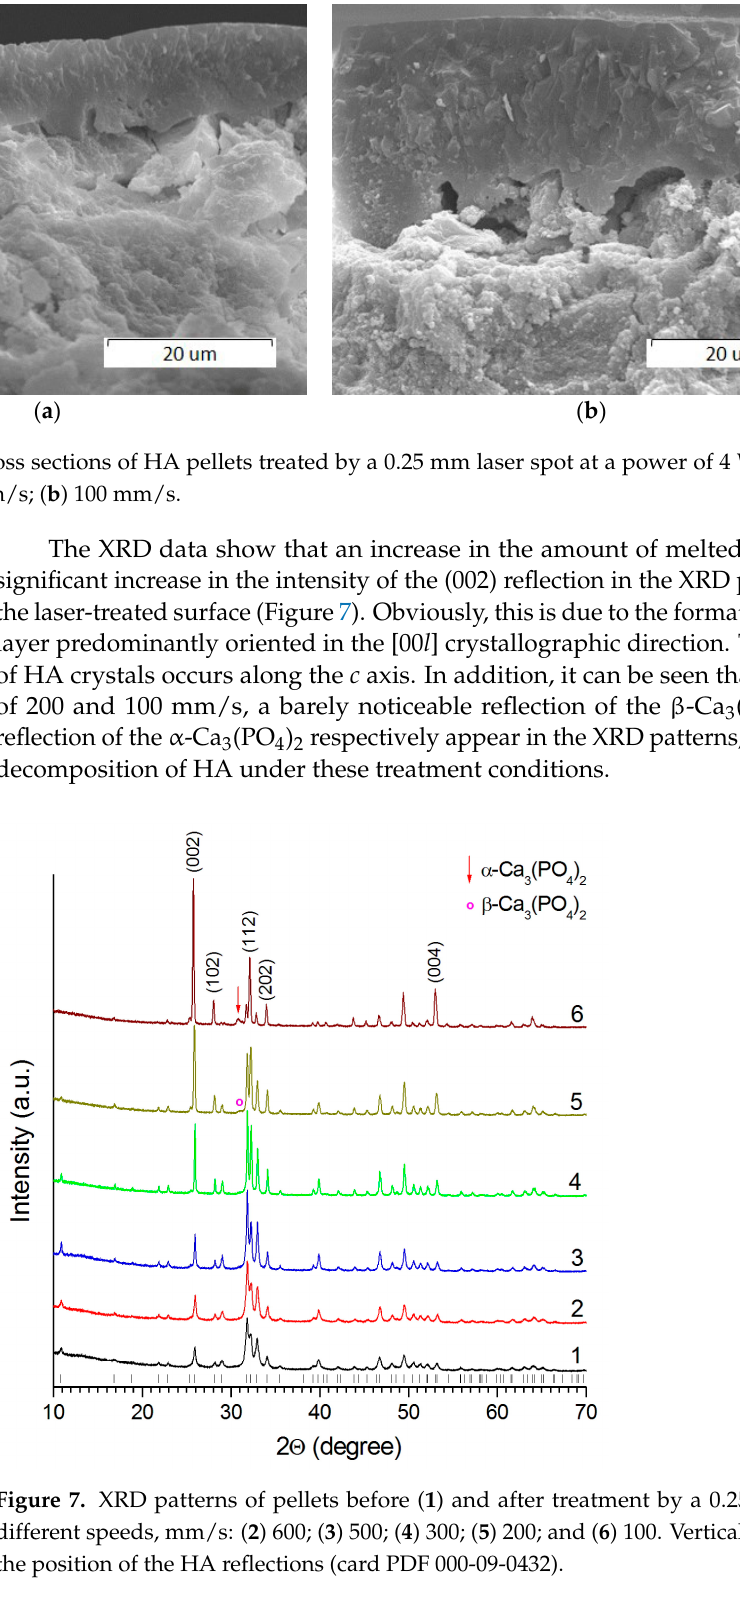
Figure 7. XRD patterns of pellets before ( 1 ) and after treatment by a 0.25 mm laser at 4 W and dif- ferent speeds, mm/s: ( 2 ) 600; ( 3 ) 500; ( 4 ) 300; ( 5 ) 200; and ( 6 ) 100. Vertical markers correspond to the position of the HA reflections (card PDF 000-09-0432).